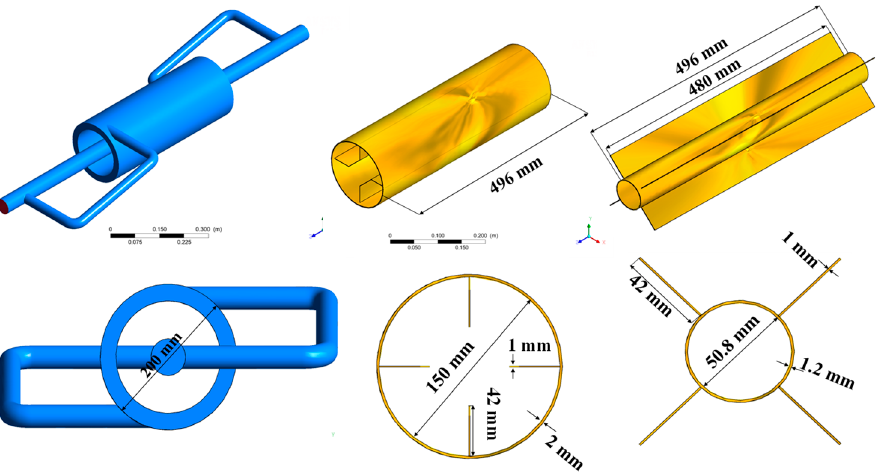
Figure 3. Side view and longitudinal section of the TTXH.